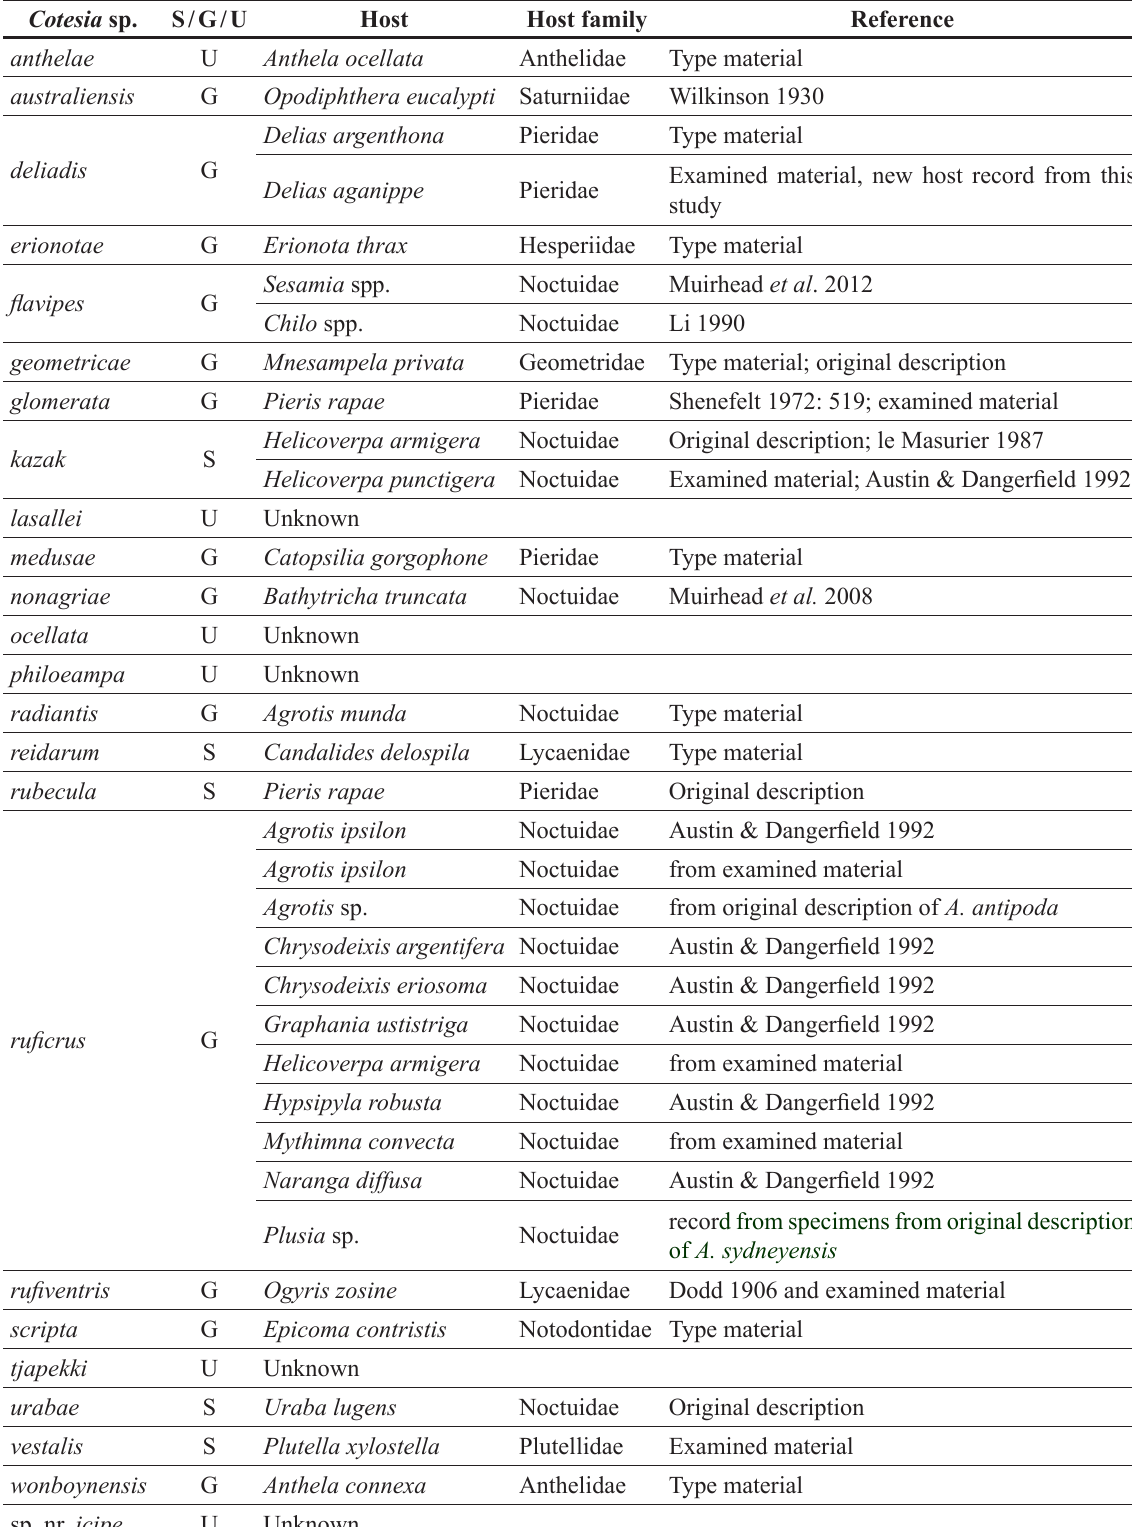
Table 1. Host-parasitoid checklist for the Australasian Cotesia fauna. Abbreviations: S = solitary; G = gregarious; U